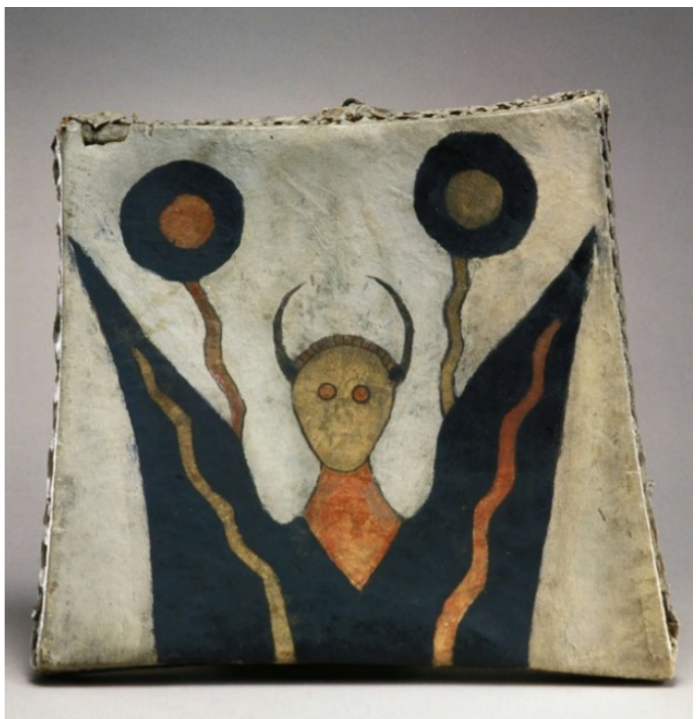
Figure 2. Hand Drum. Attributed to Siyosapa (Hunkpapa/Yanktonai), Collected at Fort Peck, Montana in 1885. Wood, rawhide, paint, 40.6 cm × 45.1 cm × 12.1 cm. Used by permission from Detroit Institute of Arts (1990.109). Gift of Mr. and Mrs. Richard A. Pohrt.